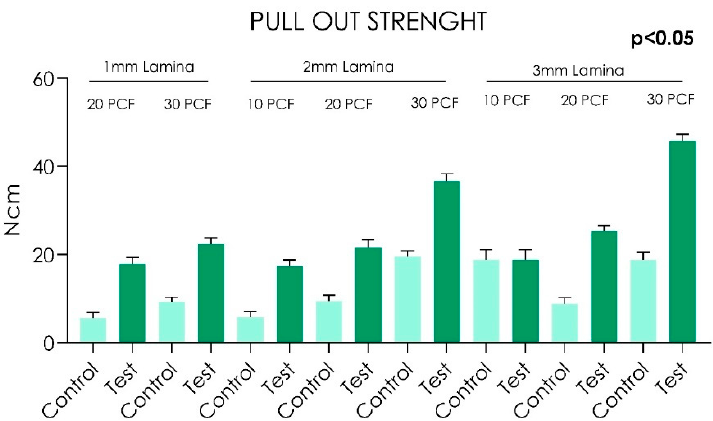
Figure 7. Evaluation for Test Implants and Control Implants in different polyurethane block conditions. Table 1. Control Implant and Test Implant Insertion Torque values measured in different experimental conditions. CI = Control Implant; TI = Test Implant.